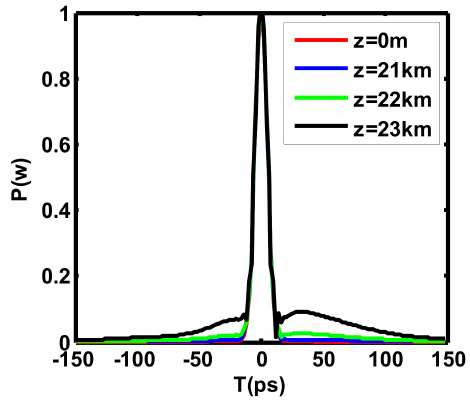
Figure 3. Pulse waveforms at different distances when β 2 =